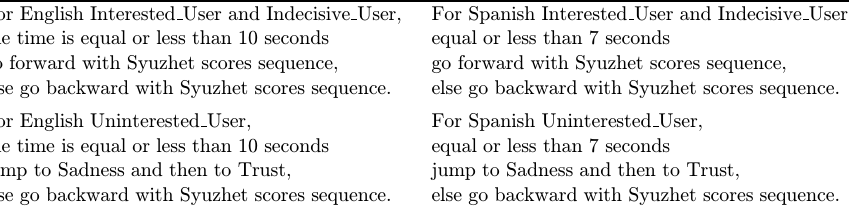
Table 4. Handling of new video